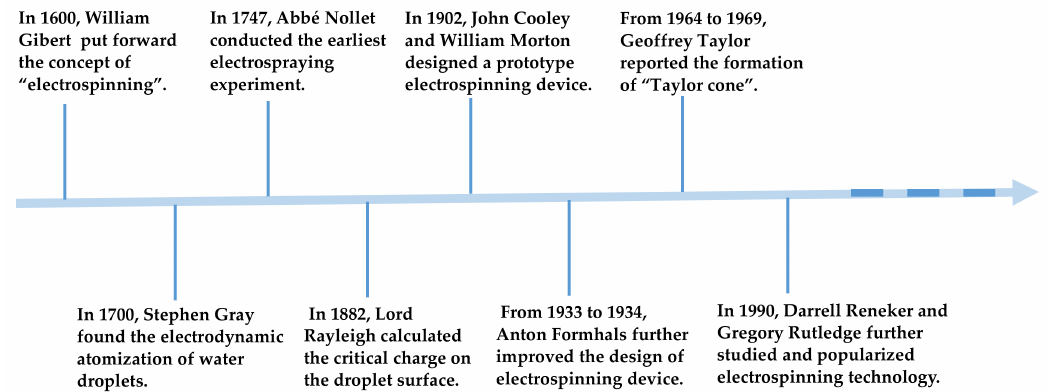
Figure 3. Initial development history of electrospinning